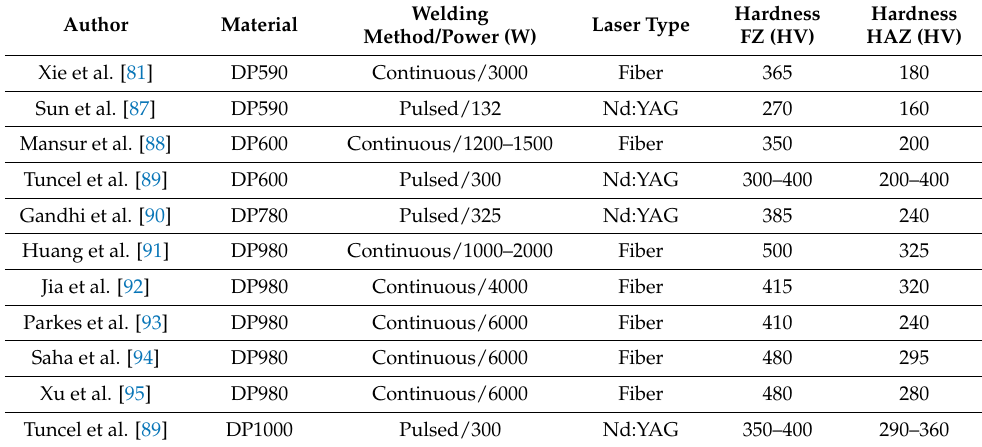
Table 3. Hardness values for several laser welded DP